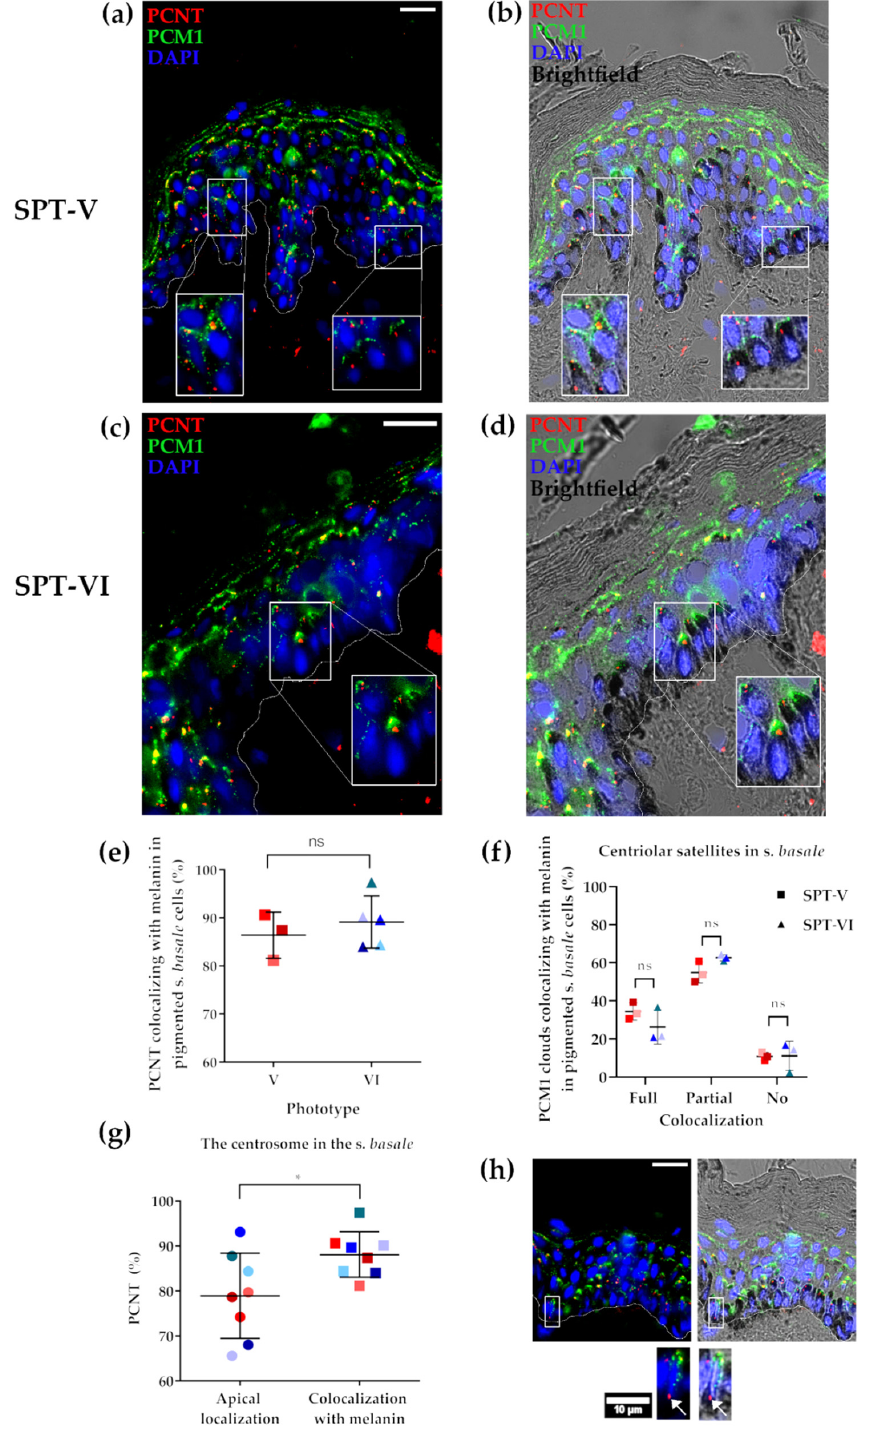
Figure 5. Co-localisation of centrosomes (PCNT) and centriolar satellites (PCM1) with melanin granules in highly pigmented human skin (SPT V and VI). ( a ) Representative image of PCNT (red) and PCM1 (green) localisation in SPT V skin. ( b )